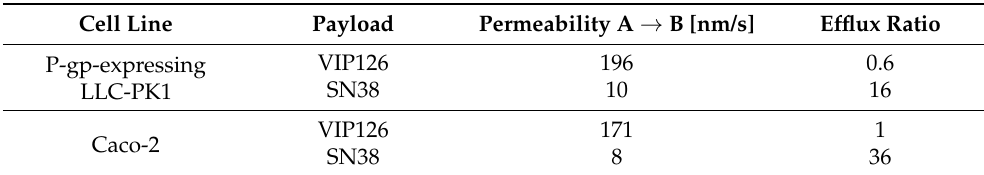
Table 1. Permeability and efflux ratio of the VIP126 and SN38 payloads measured in flux assays with human P-gp-expressing LLC-PK1 cells and Caco-2 cells. The values represent the mean value of at least two independent assays performed in triplicate ( n = 3).